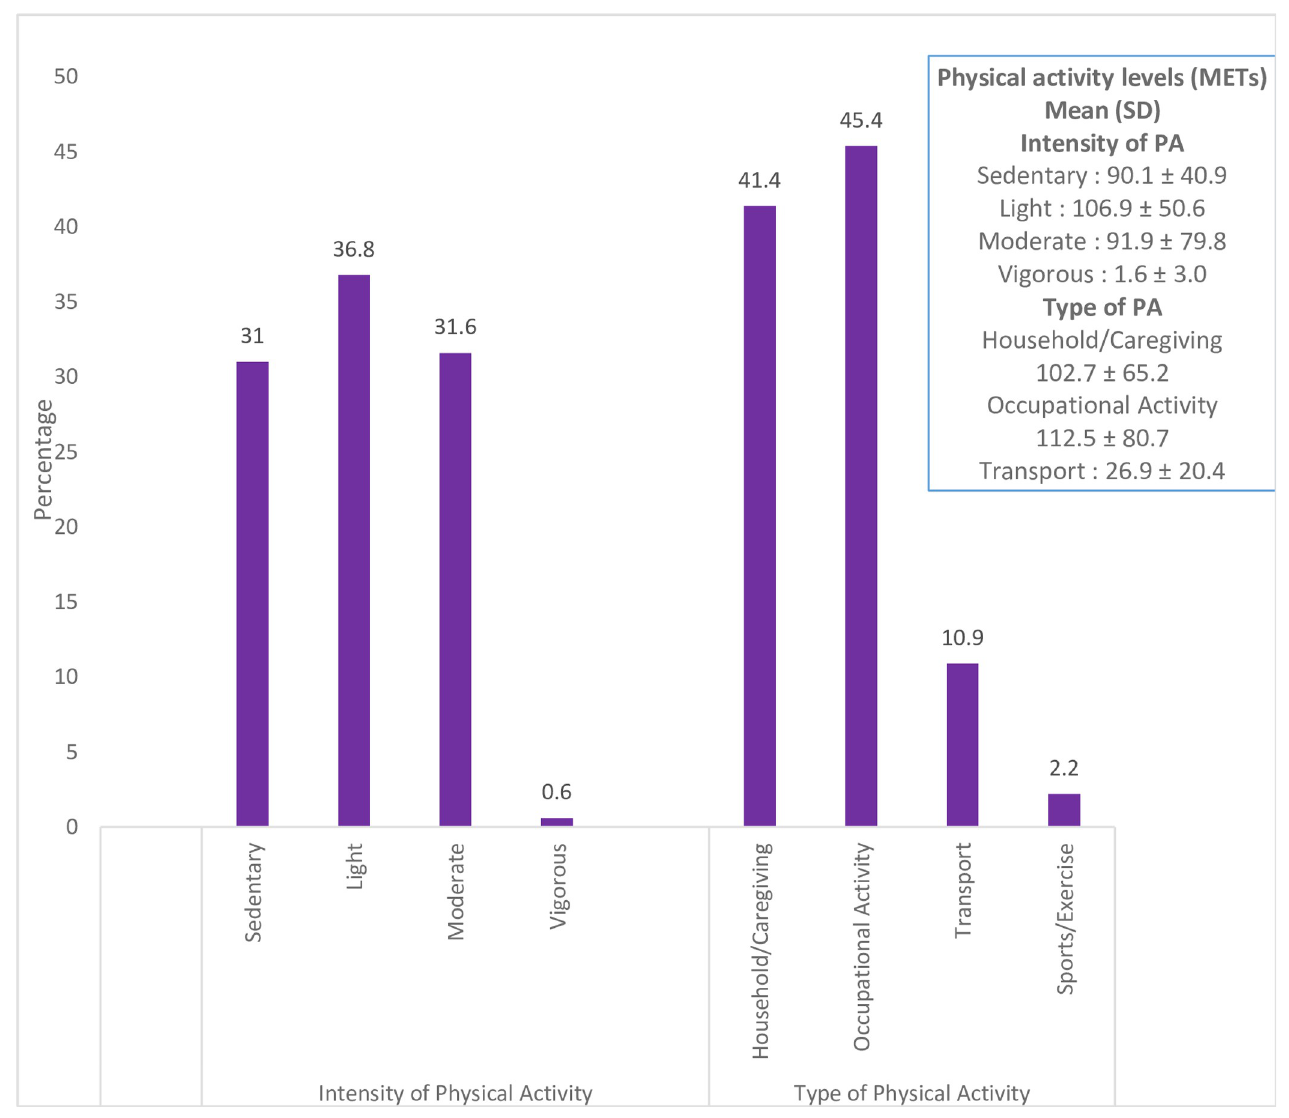
Fig 1. Intensity and types of physical activity during